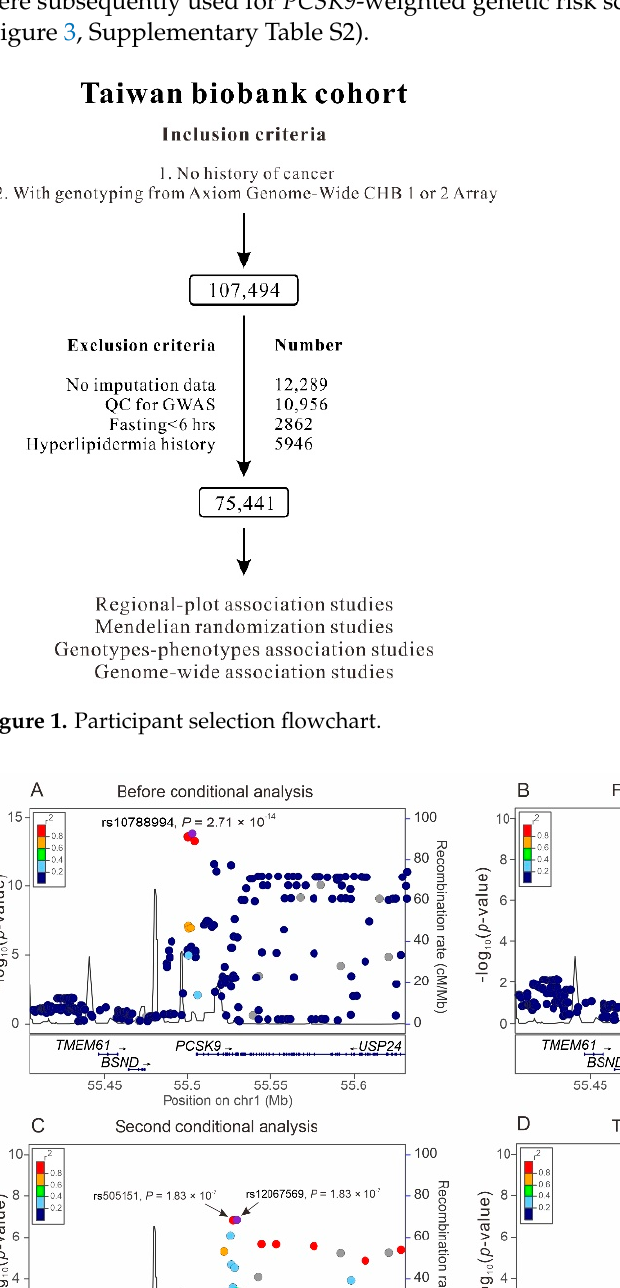
Figure 2. Regional association plots in a region of 200 kb surrounding the PCSK9 locus on chromo- some 1p32 for low-density lipoprotein cholesterol levels. Regional plot associations are shown with- out ( A ) or with serial conditional analysis after further adjustment for rs10788994 ( B ), rs565436 ( C ), and rs505151 ( D ) genotypes.